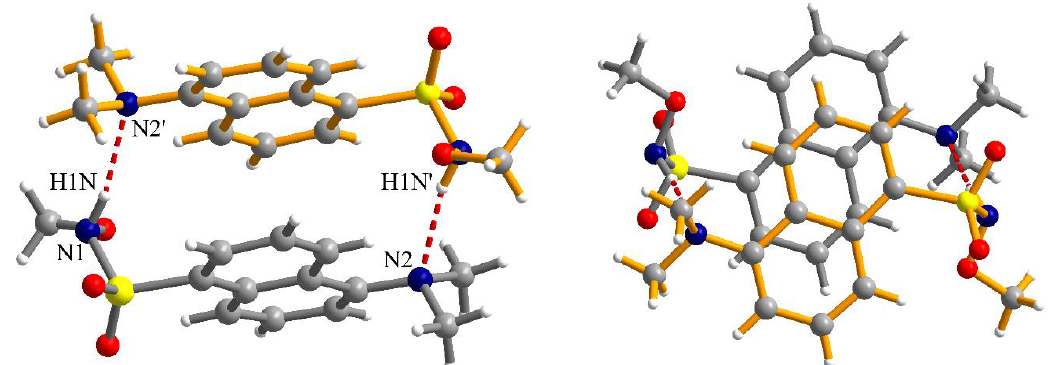
Figure 5. Two different views of the supramolecular dimers formed by hydrogen bonding and π − π interactions in crystal 2 (symmetry code: ’ = 1–x, 2–y, –z); views are perpendicular to each other.